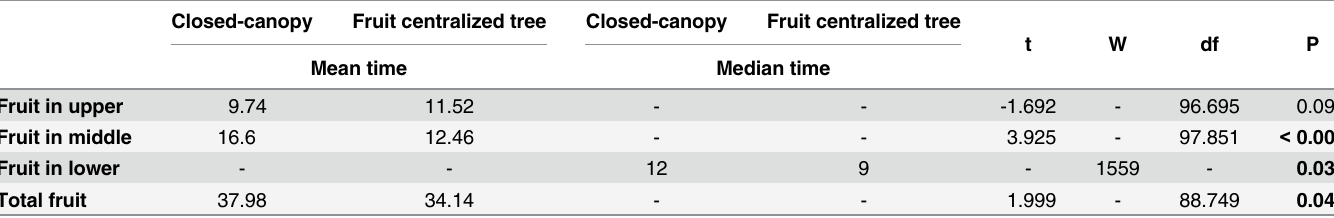
Table 4. The comparison of mean/median time (min) spent by 30 Bactrocera tryoni on host fruit in each part of two treatments. Closed-canopy Fruit centralized tree